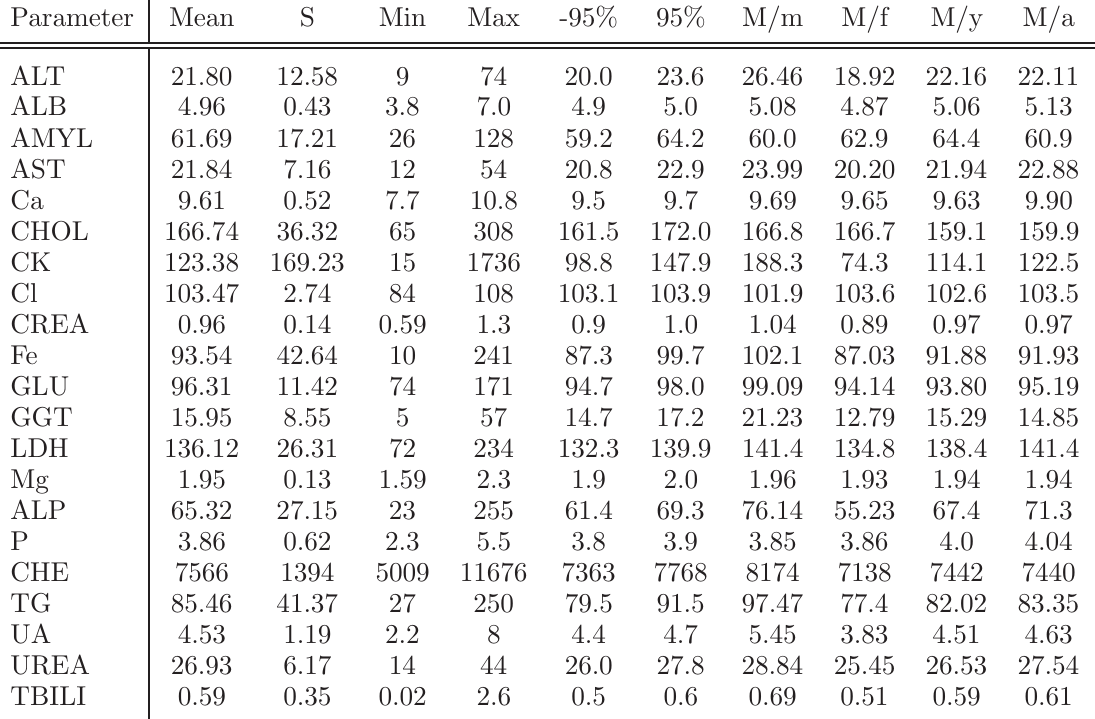
Table 2 Basic statistics for the tested clinical parameters for all healthy individuals (N=185, mean value, standard deviation of the mean, confidence interval, minimum and maximum values within a certain variable). For comparison, the mean values of the parameters for the separate subgroups (male, female, young, adult, marked as M/m, M/f, M/y, M/a) are also